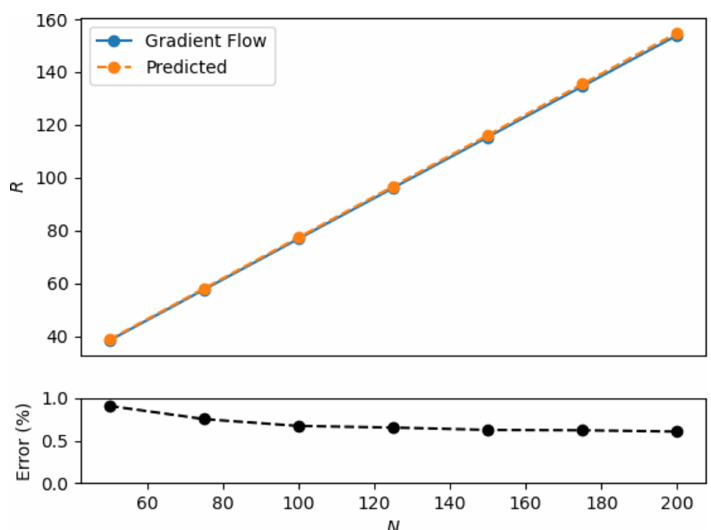
Figure 12 . A comparison of the predicted radii to the radii of vorton solutions in parameter set C, to be compared with figure 10, where the parameter set is the same, except set C has a stronger gauge coupling of G = 1 . The ratio Q/N = 31 . 89 is kept fixed. This has improved the accuracy of the predictions and increased the energy minimising